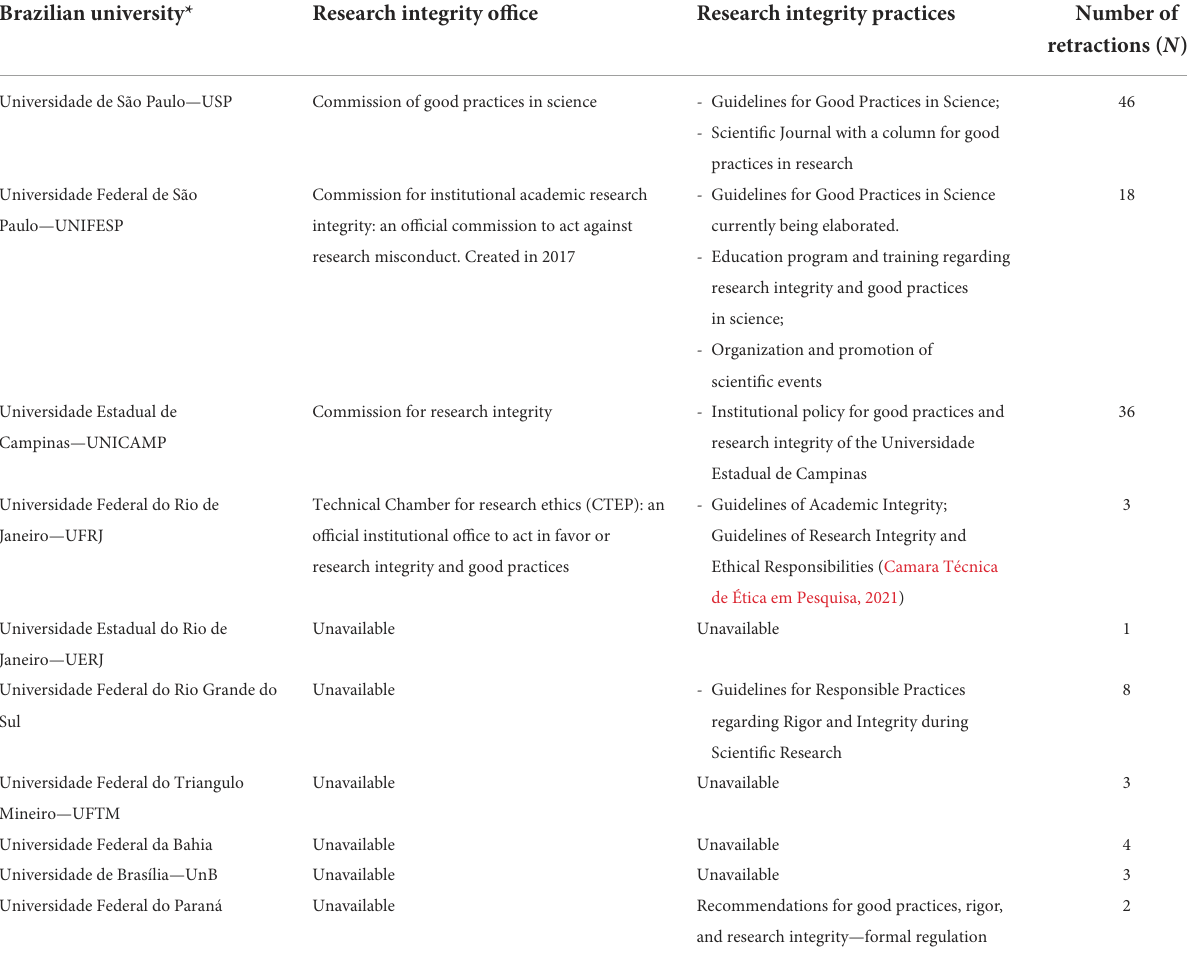
TABLE 2 Research integrity policies of Brazilian universities who are involved with